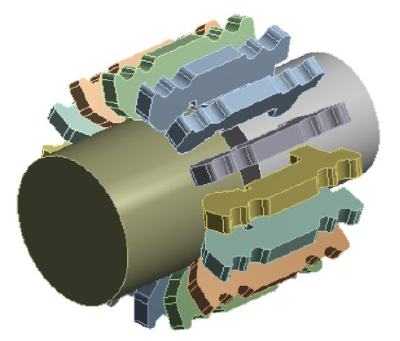
Fig. 1. The overall model of plum blossom contact